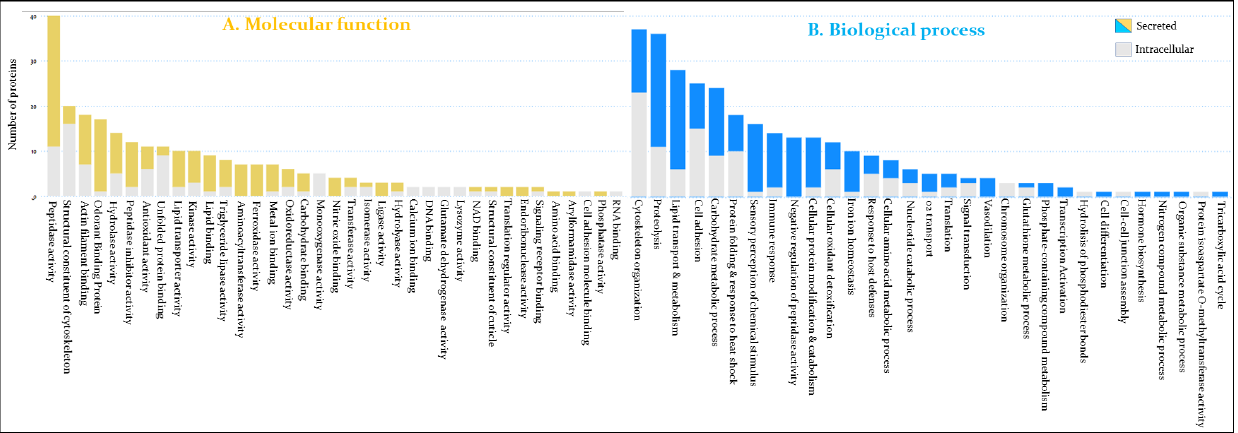
Figure 2. Functional annotation of R. prolixus hemolymph proteins. The proteins have been classified according to their molecular function ( A ) and biological process; ( B ) according to Gene Ontology. Exhaustive information about the identified proteins is provided in Table S1.